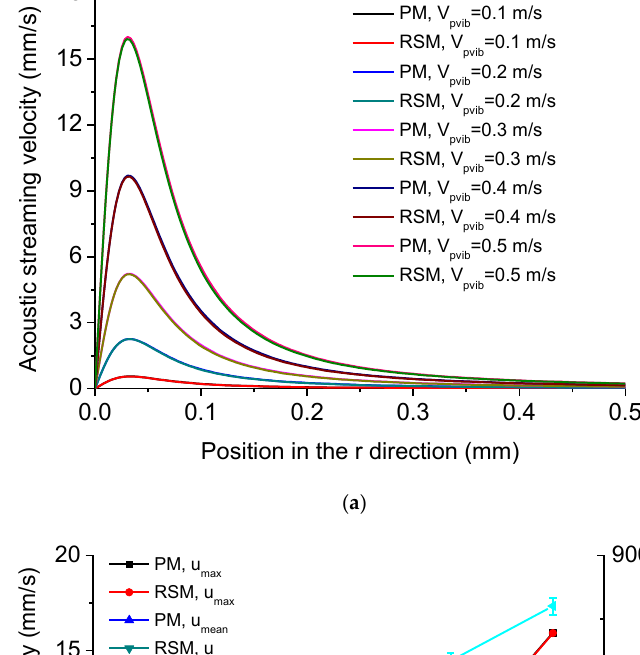
versus f p . In Figure 6b, the SRD versus f p was measured with five Langevin transducers with different resonance frequencies (20 kHz, 28 kHz, 40 kHz, 51 kHz, 60 kHz). It is seen from Figure 6b that both u max and u mean decrease with the increase of f p , which accounts for that the SRD decreases with the increase of f p . This result indicates that the lower driving frequency is beneficial to removing micro/nanoscale particles within larger areas. Figure 6c shows D of u max and D of u mean versus f p , respectively, and it is seen that D of u max decreases with the increase of f p . This is because that although V pvib is kept the same, the higher input frequency corresponds to the higher input power for the acoustic field [91], in which case F add becomes less significant compared to F R when f p increases in this system.